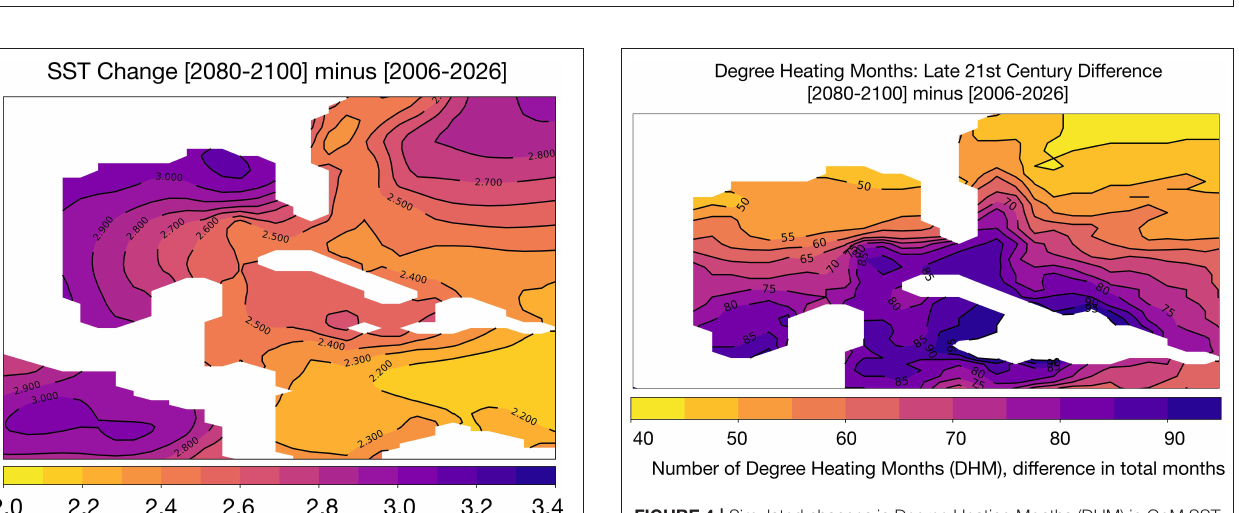
FIGURE 2 | Projected mean Gulf of Mexico SST for 2080–2100, RCP8.5 Large Ensemble, CESM1.2, with all reported Gulf of Mexico reef organism locations overlain. Colors of coral sites indicates reef organism depth [meters] and symbols denote type of reef builder, as in Figure 1 . Continental regions are shown in white.